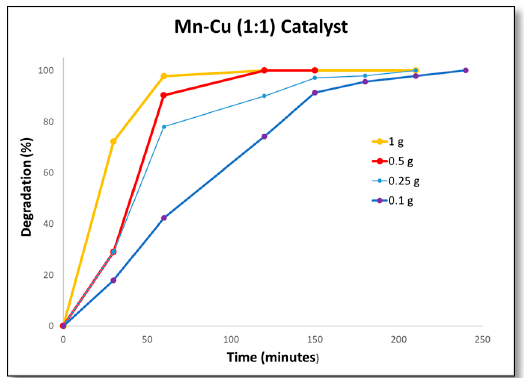
Figure 4. Effect of the catalyst loading in the catalytic wet peroxide oxidation (CWPO) of crystal violet (CV) .